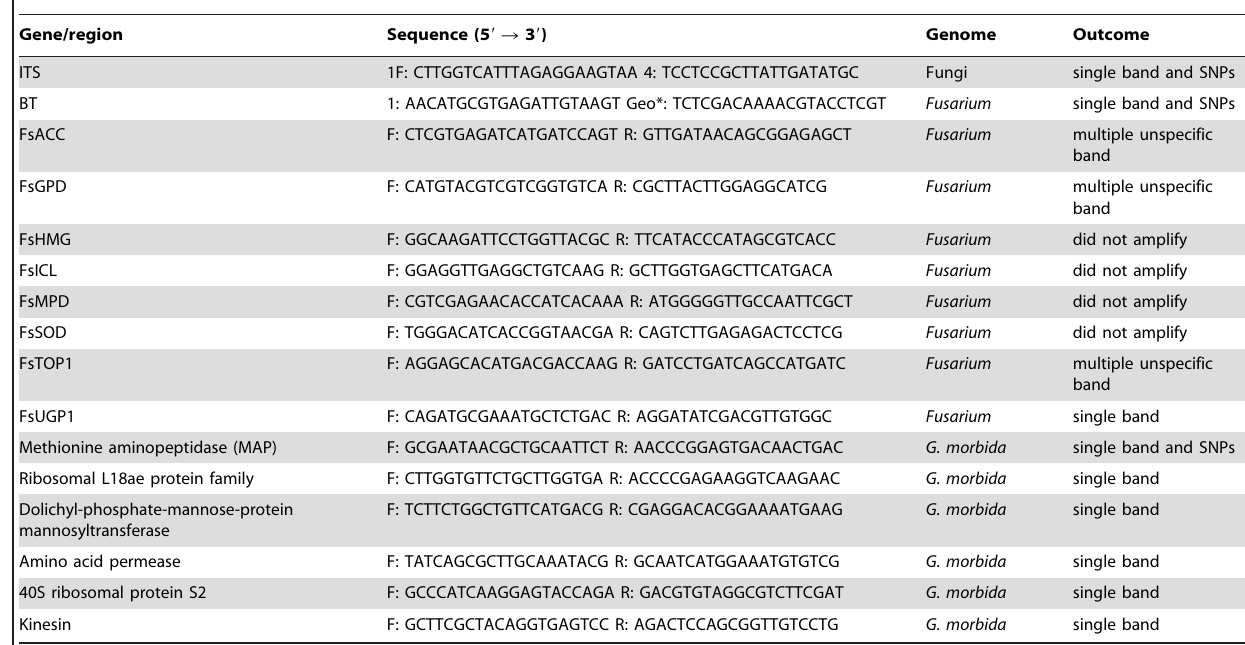
Table 2. Primers tested on MLST analysis of Geosmithia morbida isolates.